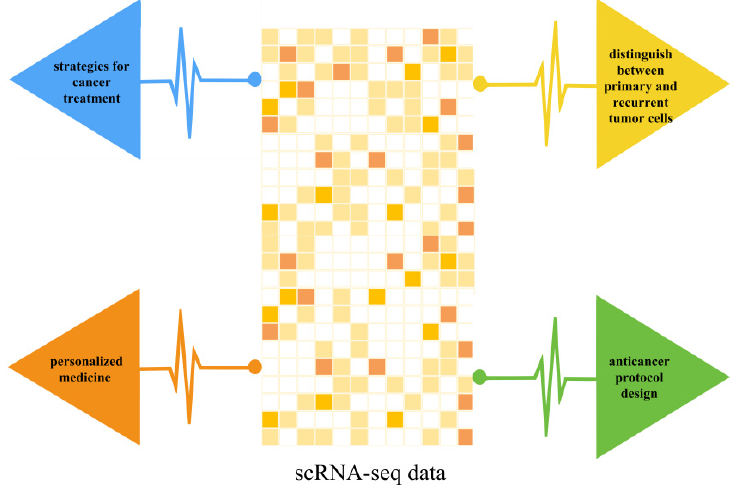
Figure 1. Application of scRNA ‐ seq data [15].